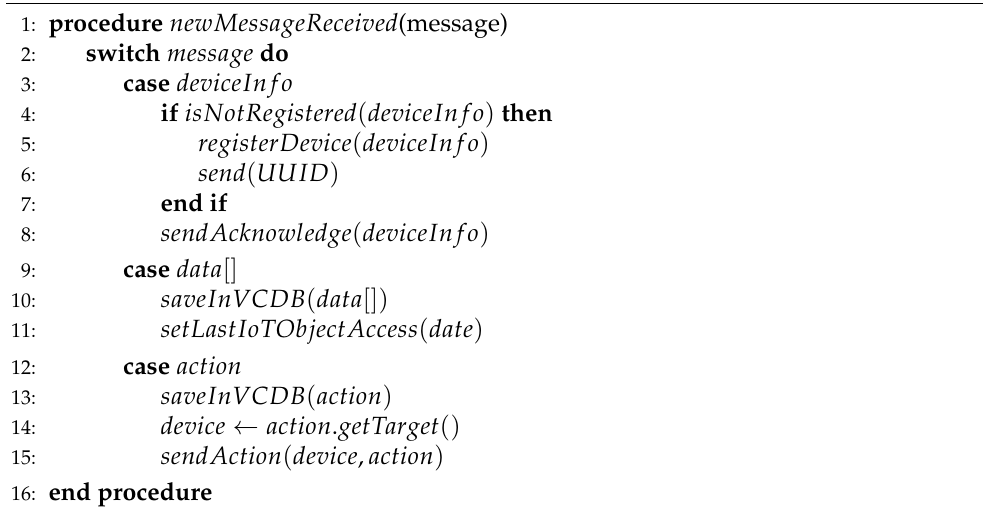
Algorithm 3. RMC algorithm for receiving